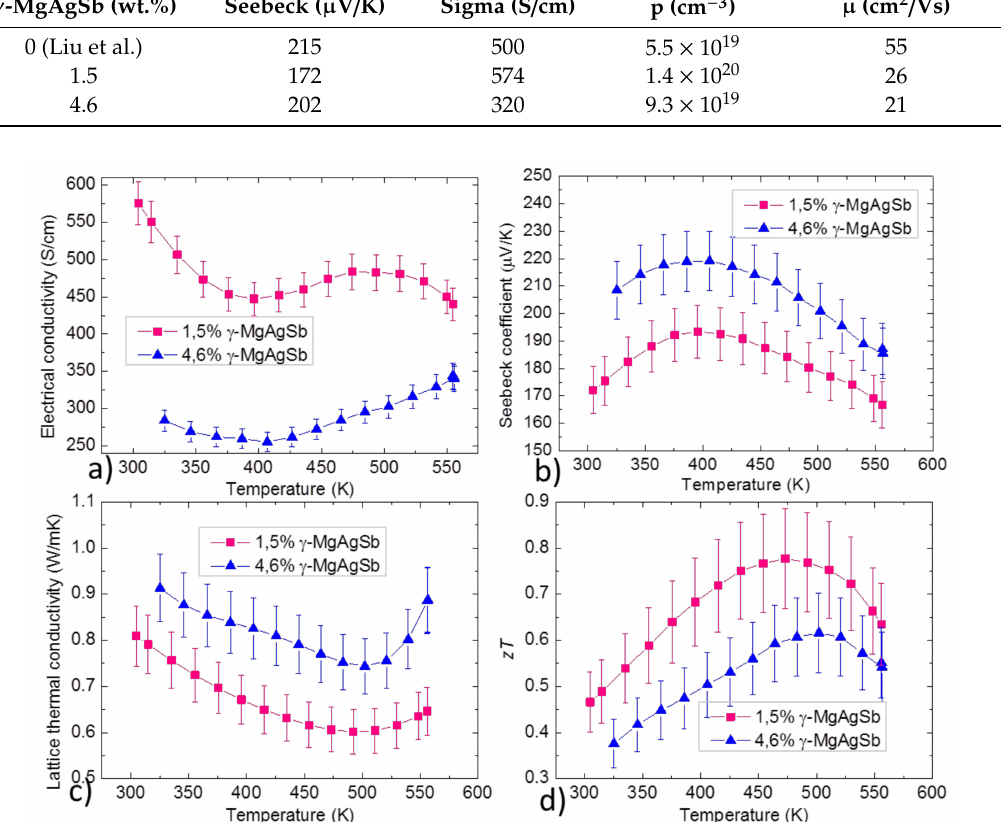
Figure 8. Comparison of temperature dependent ( a ) electrical conductivity, ( b ) Seebeck coe ffi cient, ( c ) lattice thermal conductivity and ( d ) figure of merit for di ff erent γ -MgAgSb contents. Both samples were made with